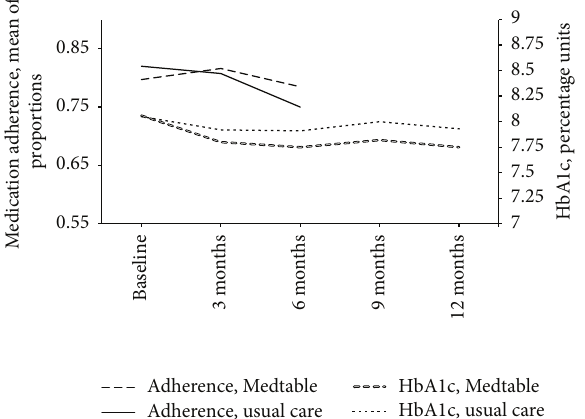
Figure 3: Medication adherence and glycosylated hemoglobin (HbA1c) before and after intervention: Medtable versus usual